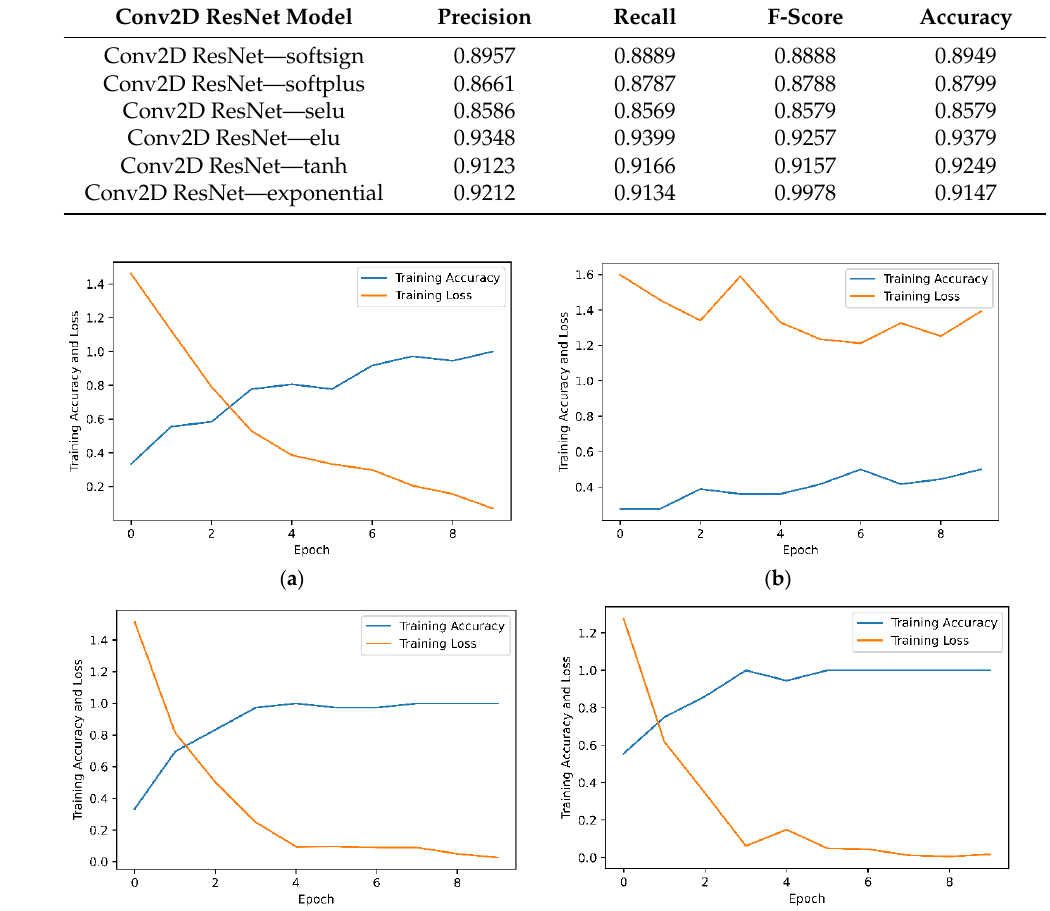
Figure 6. Model accuracy and loss of Conv2D models during cross validation. ( a ) Model accuracy of Xception; ( b ) model loss of Xception; ( c ) model accuracy of VGG19; ( d ) model loss of VGG19.